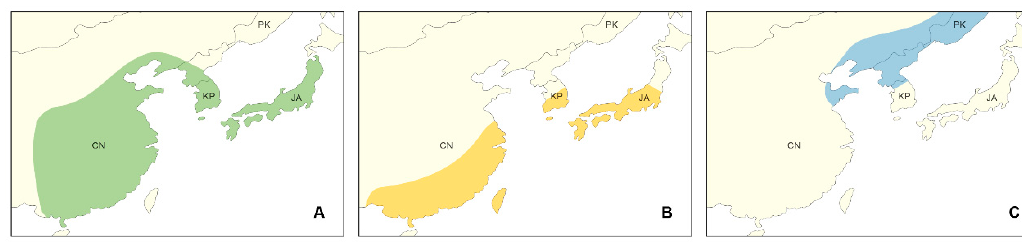
Figure 1. The schematic distribution of three Rosa sect. Synstylae species. ( A ) Rosa multiflora in the Liaoning–Shandong flora; ( B ) Rosa luciae in the Southern Chinese–Japanese flora; ( C ) Rosa maximowicziana in the Amur flora. CN: China; KP: Korean Peninsula; PK: Primorsky Krai, Russia; JA: Japanese Archipelago. Table 1. The ecological, morphological, and phenological characteristics of three species of Rosa sect. Synstylae . Characteristics Habitat Growth habit Erect Prostrate Not leathery Leathery Not